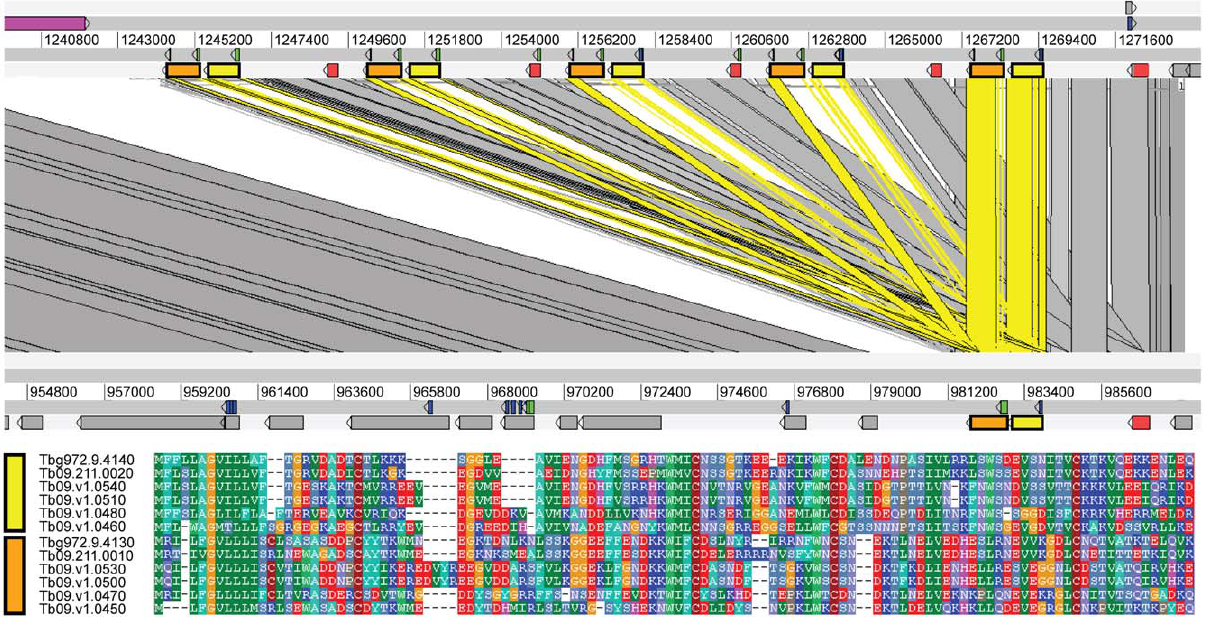
Figure 2. Segmental duplication on chromosome 9 in T.b.brucei . A single segment in T. b. gambiense comprising three coding sequences (Tbg972.9.4160, 4140 and 4130) corresponds to a three-gene segmental duplication (5 repeats) on chromosome 9 in T. b. brucei . The first coding sequence (shaded red) is a conserved, hypothetical gene encoding a putative secretory protein and all copies are identical. The second (shaded yellow) and third (shaded orange) coding sequences are tandem-duplicate, conserved hypothetical genes encoding putative membrane-bound proteins. Both second and third genes contain substantial sequence variation in T. b. brucei ; the upstream-most copies are orthologous to the T. b. gambiense genes, but none of the remaining variants were identified among T. b. gambiense sequence reads. The segmental duplication is preceded immediately upstream by an INGI-mediated insertion (shaded purple).